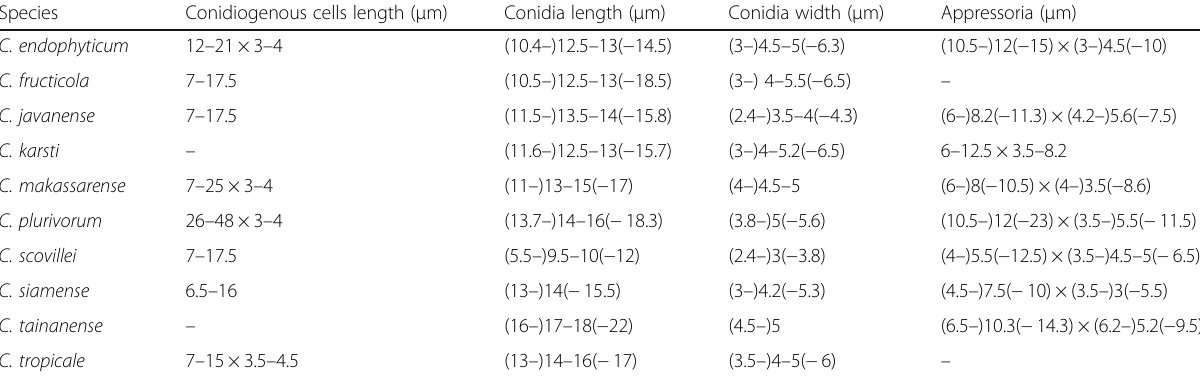
Table 4 Morphological characteristics of Colletotrichum species causing anthracnose of chili Species